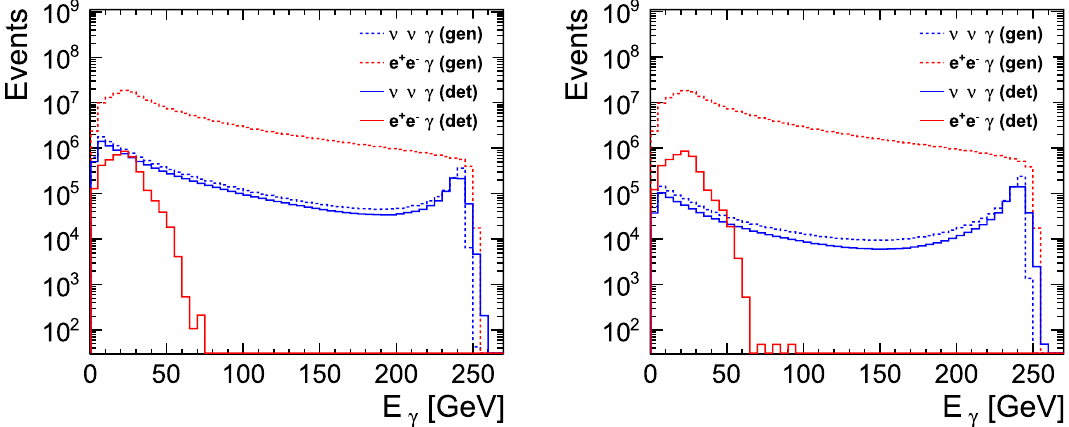
Fig. 5 Energy distributions for central photons emitted in radiative neutrino pair production events and radiative Bhabha events. Distributions expected for selected mono-photon events, after detector response simulation with Delphes (solid lines), are compared with generator level results from Whizard (dashed lines). Numbers of events presented correspond to the integrated luminosity of 1.6ab − 1 , for ILC running at 500GeV with